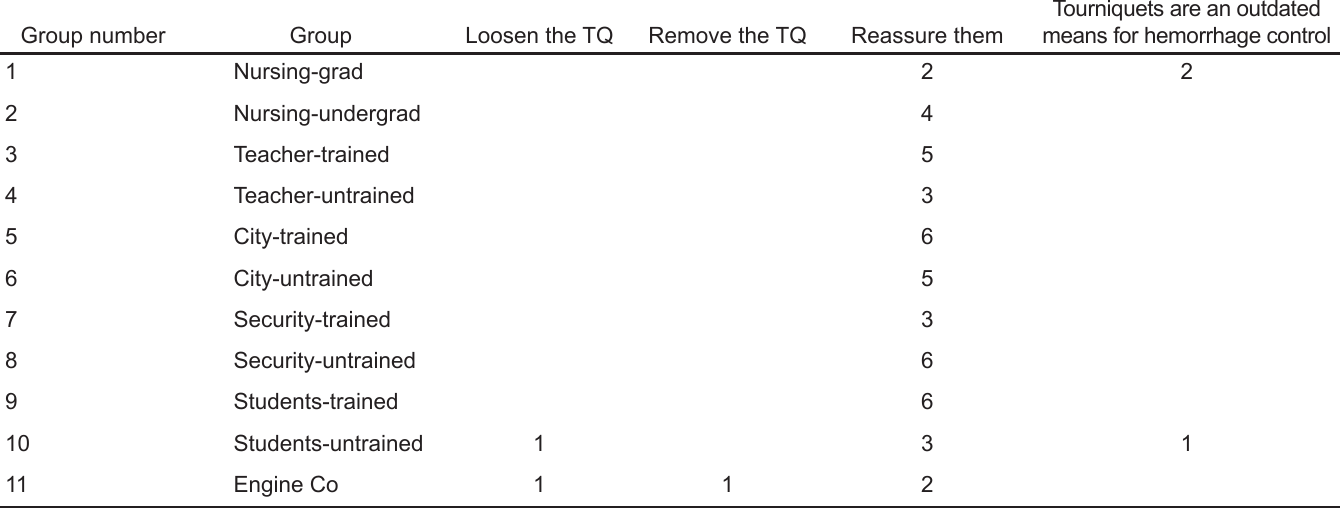
TQ, tourniquet; grad, graduate; undergrad,